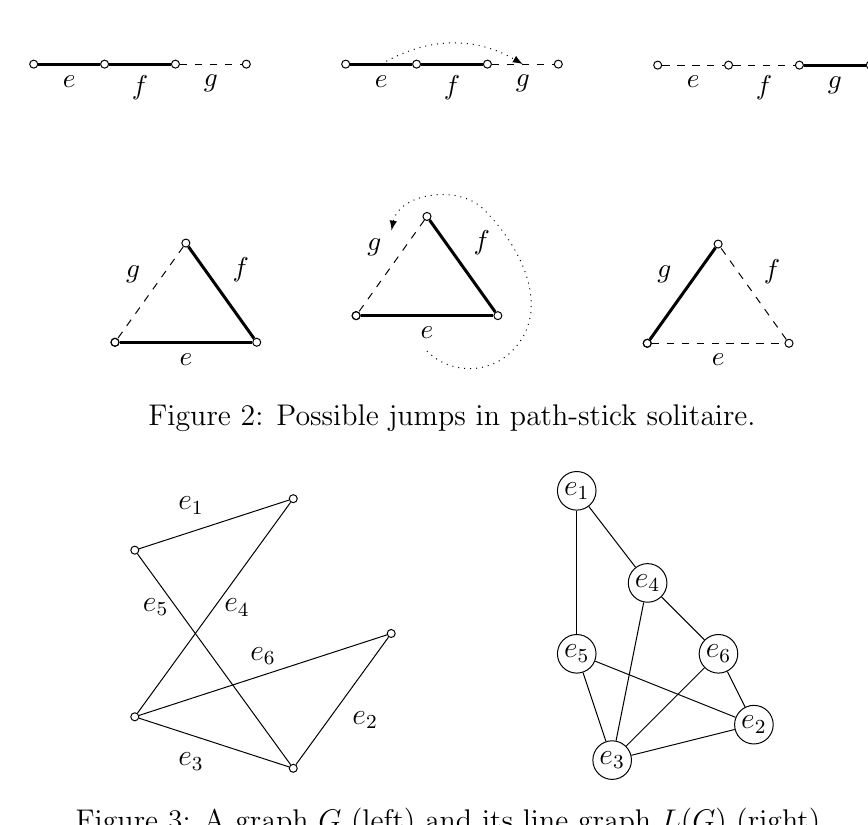
Figure 3: A graph G (left) and its line graph L ( G )